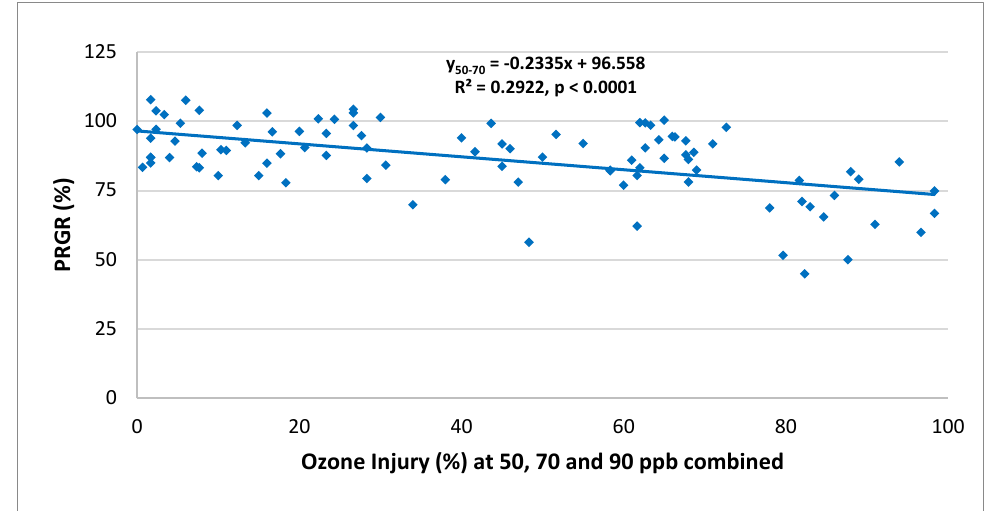
Figure 15. General relationship between percent relative growth rate (PRGR) and O 3 injury on third–fifth leaves of seven rust near-universal susceptible genotypes of bread wheat after exposure to different O 3 levels (50, 70, 90 ppb) for 14 days (12 h/day), in OPECs (at 25 °C and 50% RH). PRGR is the relative growth rate of individual plants referenced to the genotype’s average RGR in charcoal-filtered air (O 3 = 5 ppb).